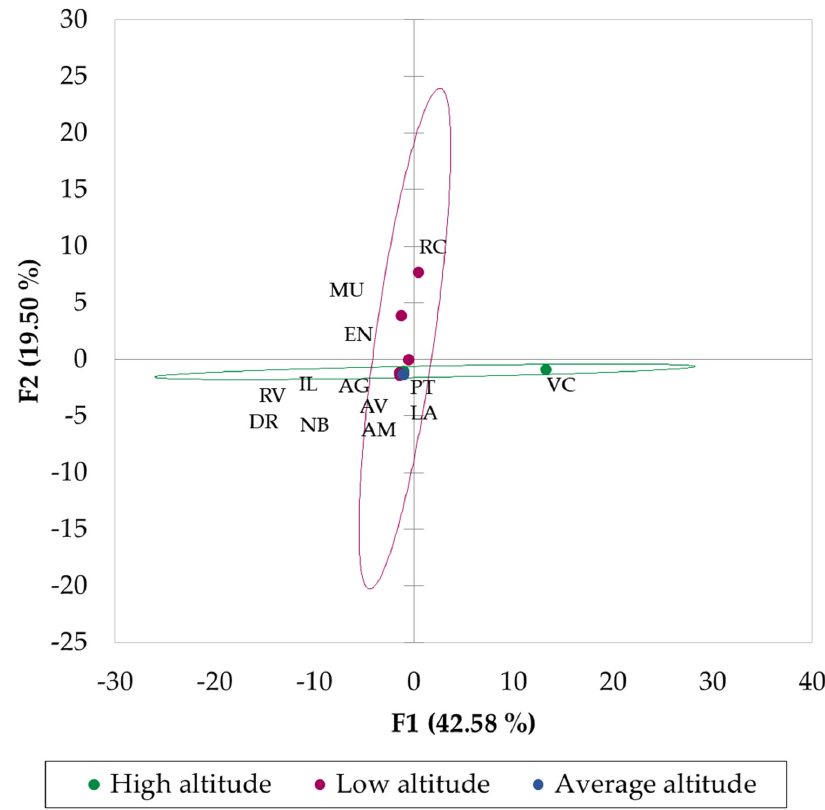
Figure 7. Representation of the samples grouped by PCA in Cartesian quadrants. The groups of samples are colored according to the different regions (altitudes) where they are produced, that is, pink (low), blue (medium), and green (high).